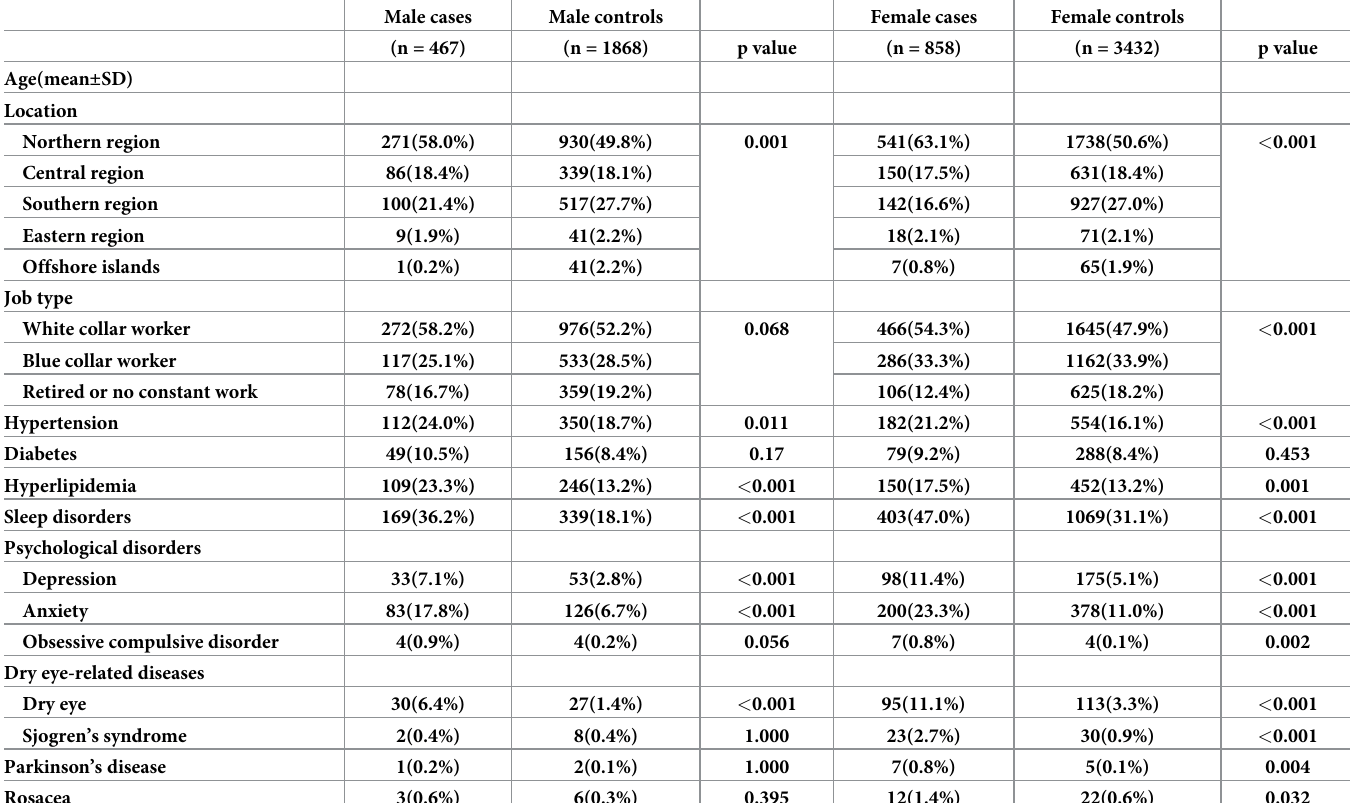
Table 3. Characteristics of male and female cases with